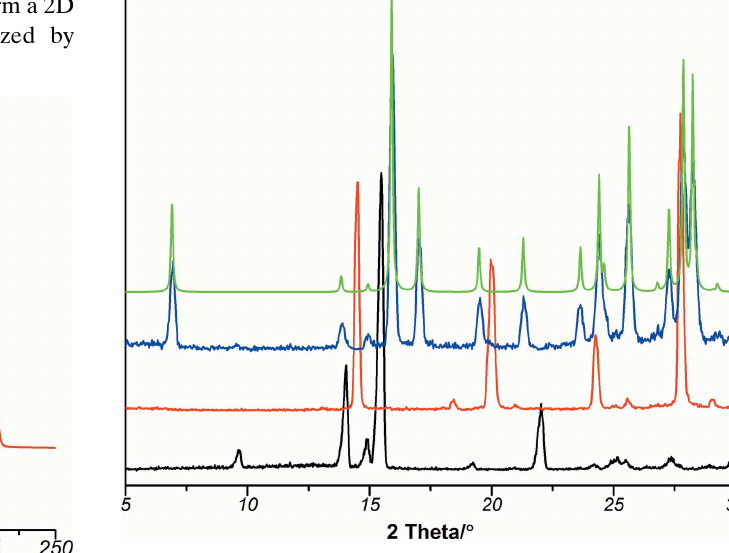
Figure 4 Comparison of the experimental PXRD patterns of